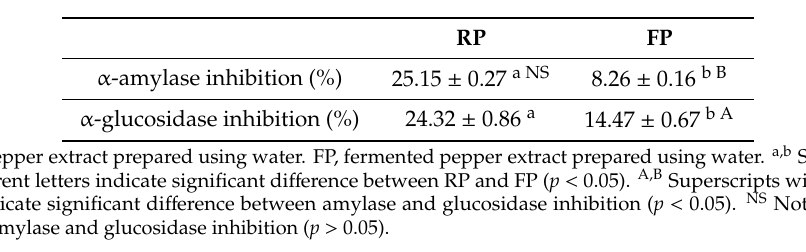
Table 4. Inhibition rates of α -amylase in raw pepper water extract (RP) and fermented pepper water extract